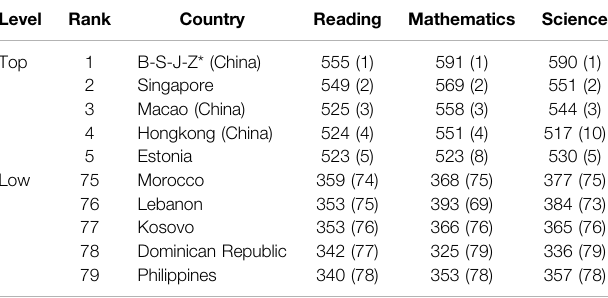
TABLE 8 | PISA 2018 results of the 5 top and low countries. Level